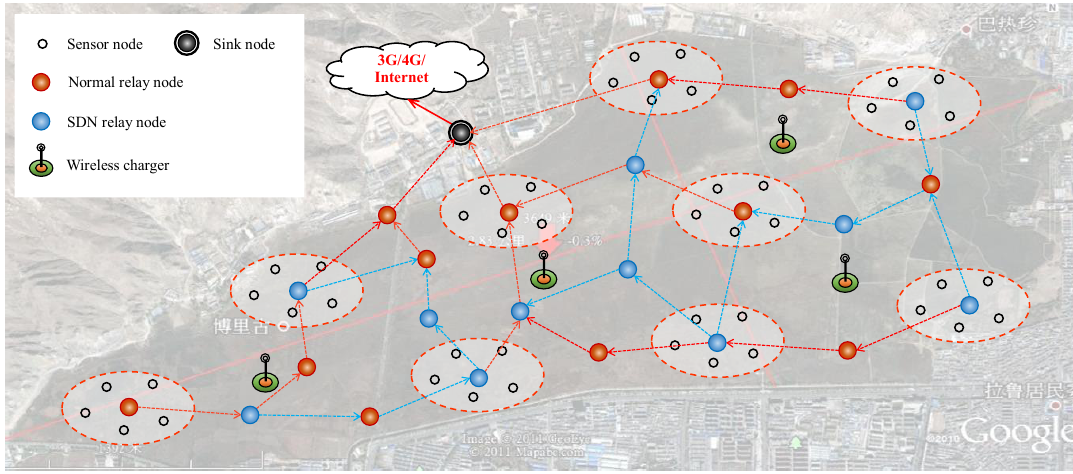
Figure 2. System